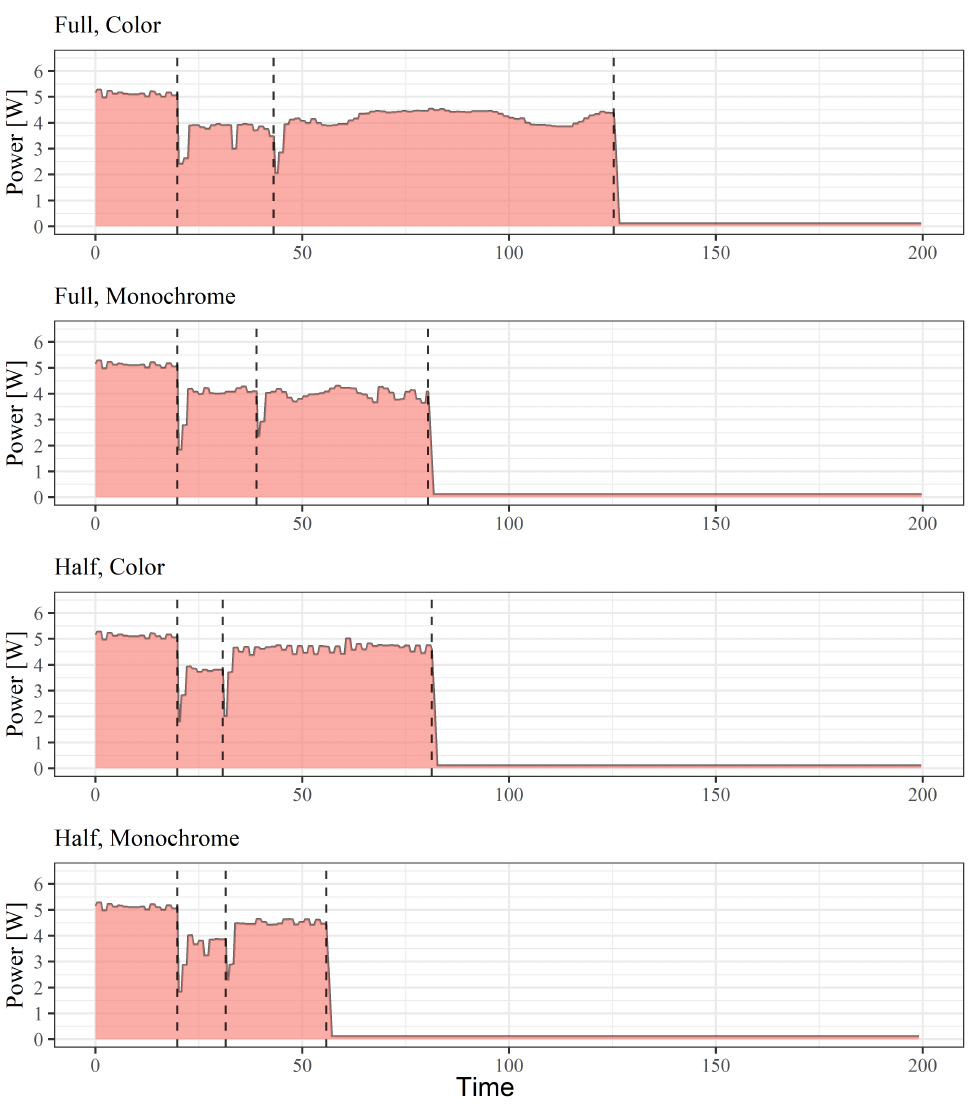
Figure 11. Power consumption for the first 200 s of a 15-min measurement cycle with a Raspberry Pi 4 at Full and Half resolution with color and monochrome images. The area under each curve represents the energy consumed during each measurement